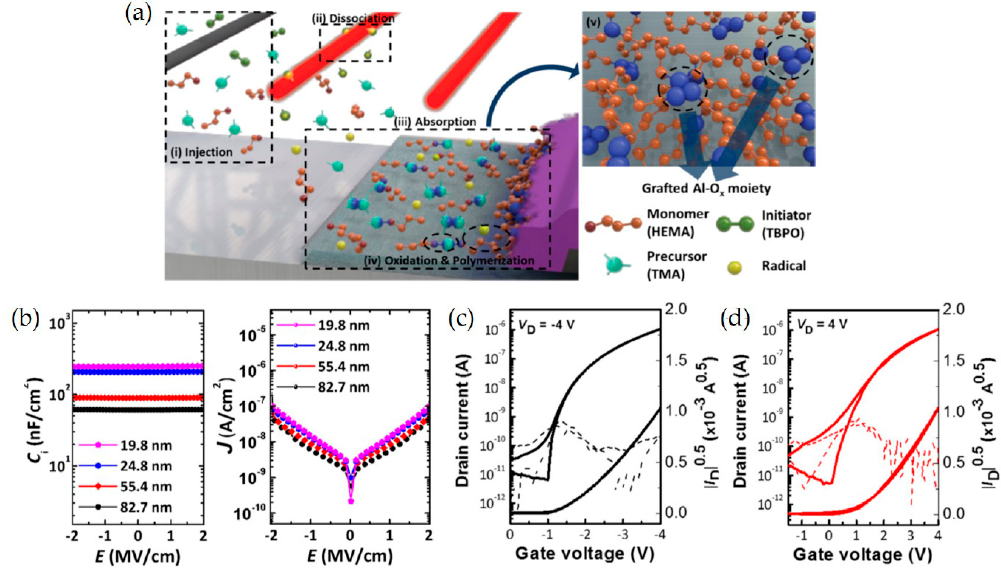
Figure 9. Vapor-phase synthesis of organic–inorganic hybrid dielectrics via iCVD. ( a ) A schematic of the synthesis process: ( i ) Vaporized monomers, organometallic precursor, and initiators are injected. ( ii ) The initiators were thermally decomposed near the heated filament to form radicals (red lines), which are positioned away from the substrate. ( iii ) Monomers, precursor, and radicals were absorbed on the